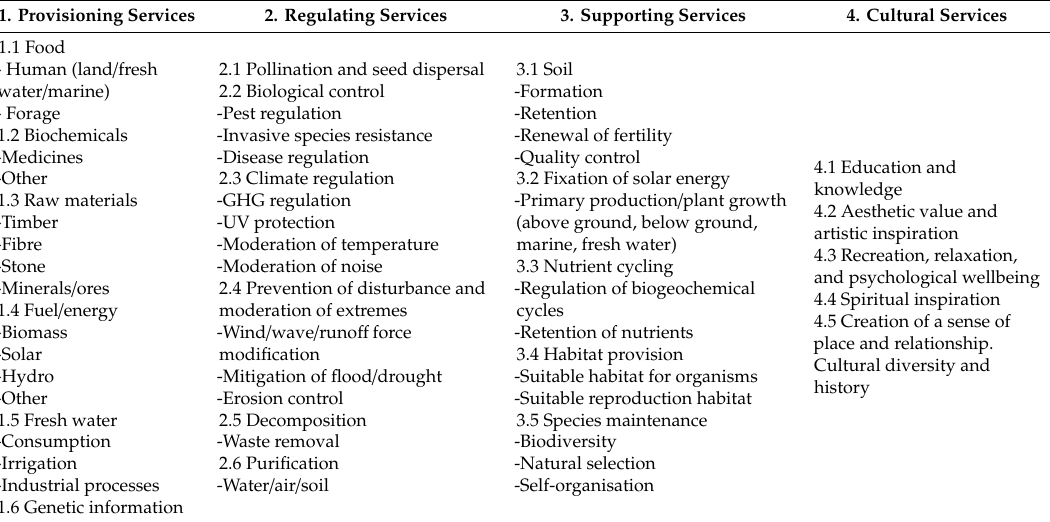
Table 1. Ecosystem services with particular reference to urban settings (adapted from Reference